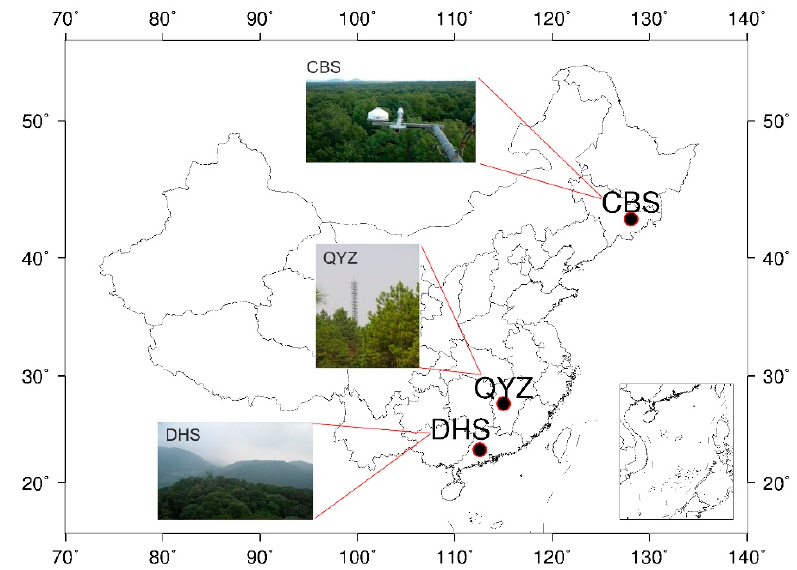
Figure 1. Locations of three ChinaFLUX forests sites. More information regarding these pictures is available at: http://www.chinaflux.org/. Table 1. The background of three ChinaFLUX forest sites [33]. Precipitation and temperature are annual mean values (http: // www.chinaflux.org /